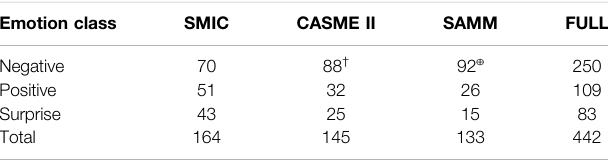
TABLE 6 | Performance of using the customized label for each region to train the spatial